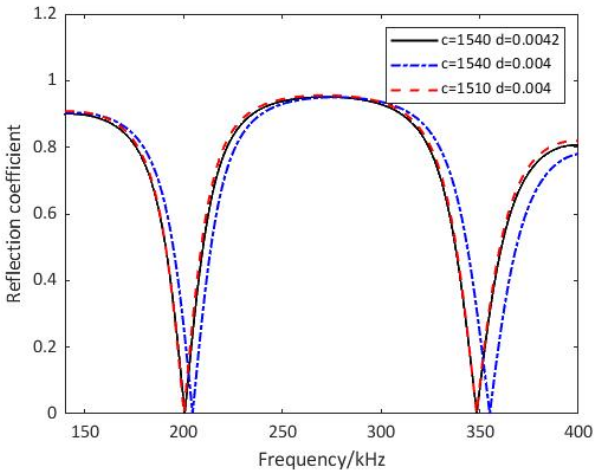
Figure 6. Comparison of frequency response curves of reflection coefficients at different layer thicknesses and different sound velocities.